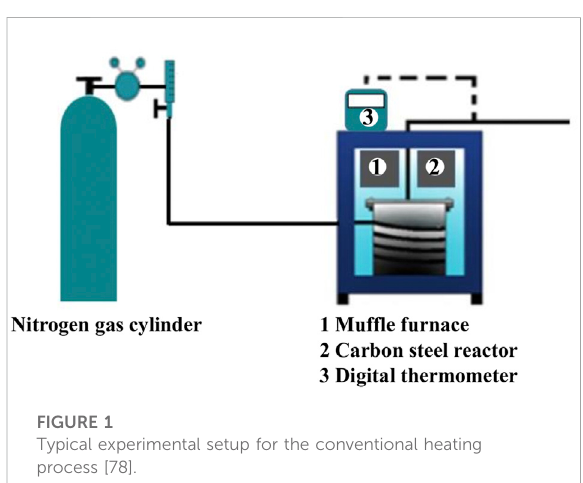
FIGURE 1 Typical experimental setup for the conventional heating process